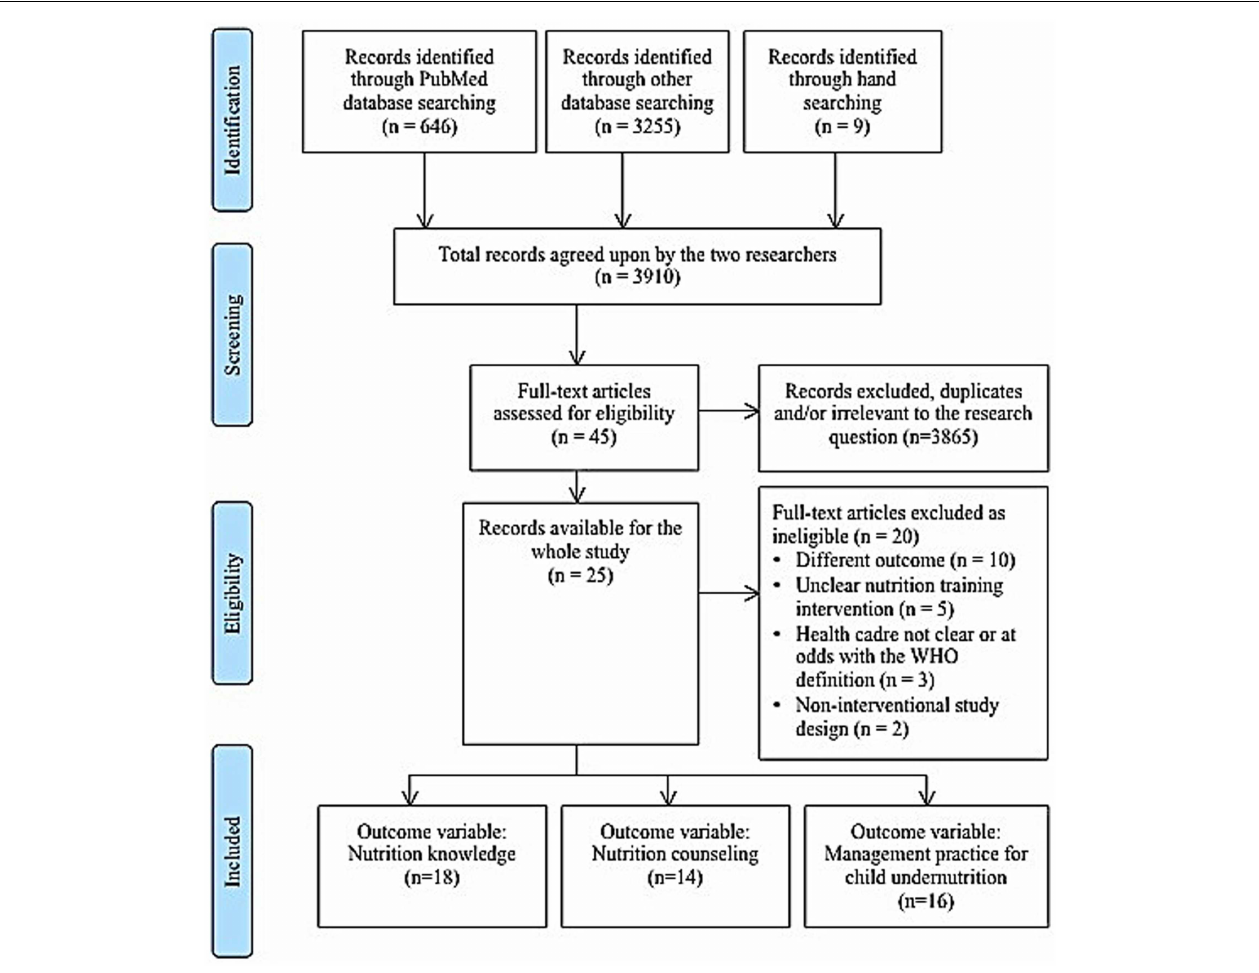
FIGURE 1 | Diagram of information flow through phases of systematic review